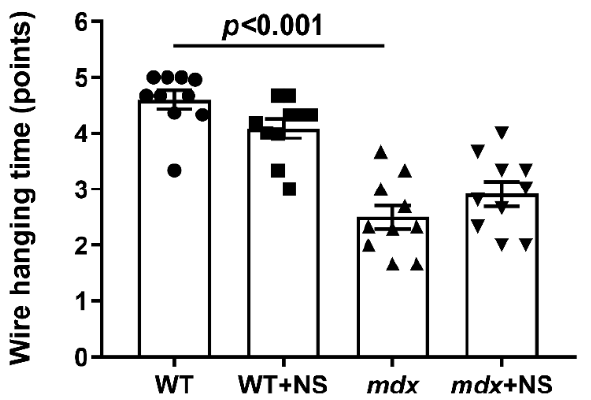
Figure 10. The effect of NS1619 on the results of the wire-hanging test, reflecting the muscle func- tion and endurance of the studied groups of mice. The data are presented as m ± SEM.